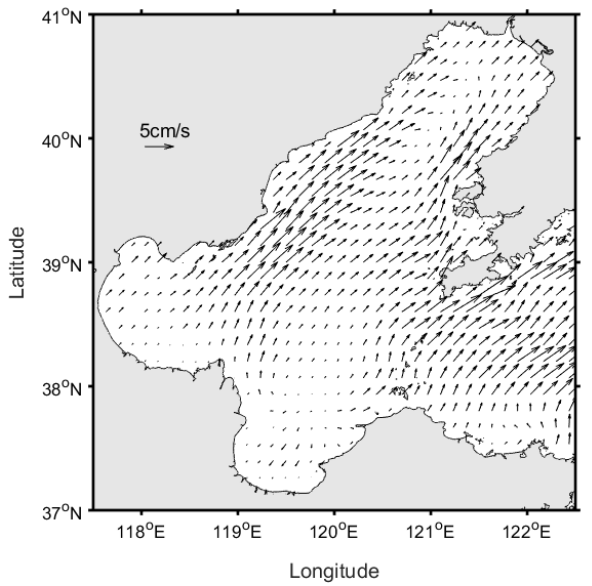
Figure 3. The surface flow field of the Bohai Sea at 0:00 am 1 June 2011.